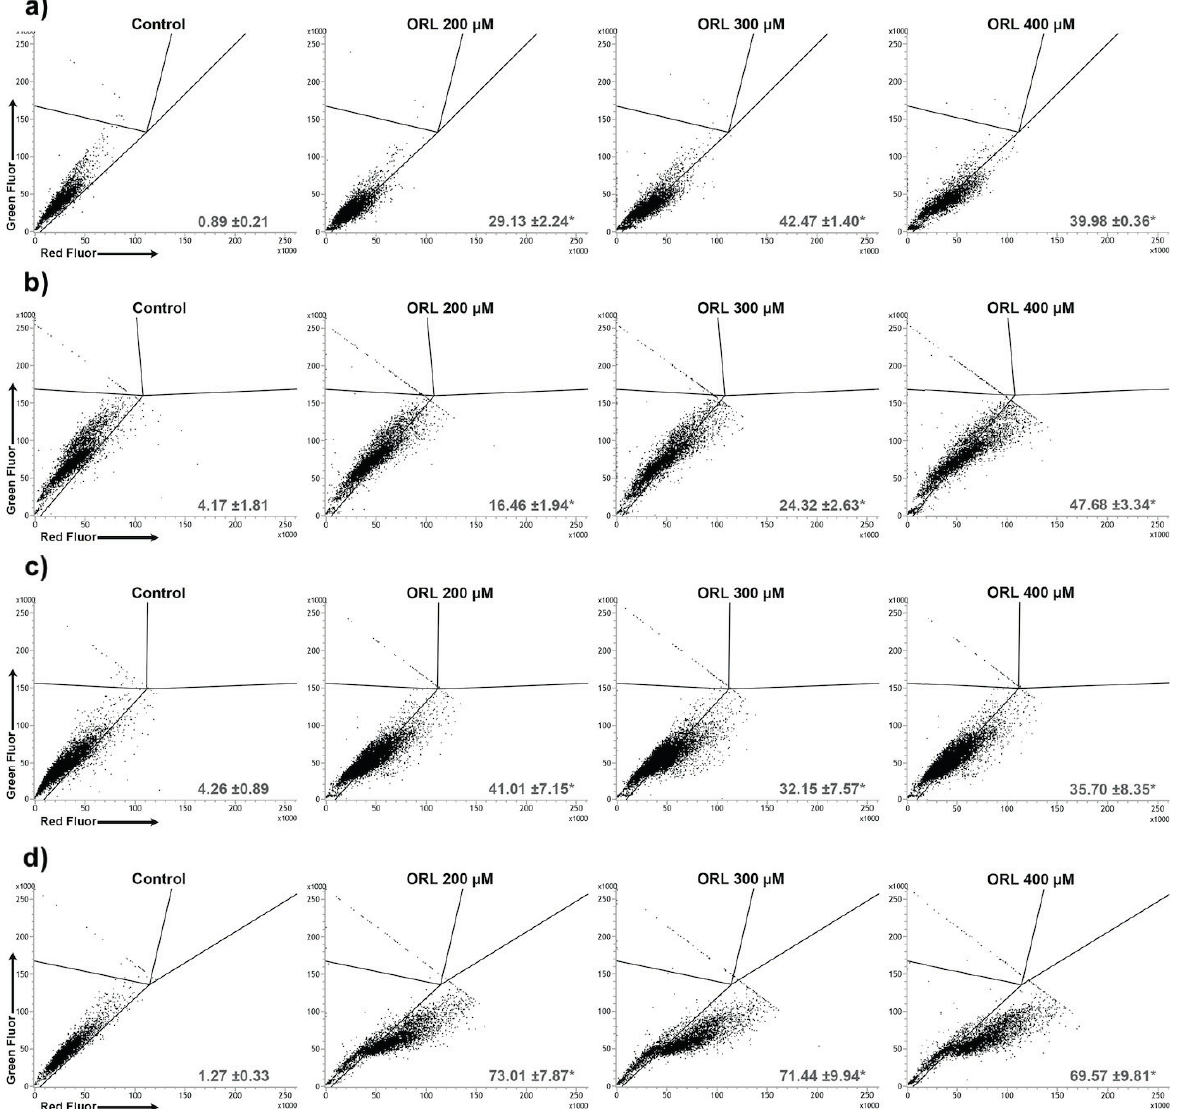
Figure 6. FASN inhibitor (orlistat - ORL) triggers autophagy in cervical cancer cell lines. Flow cytometry showed an increase in acridine orange (AO)-marked cells in the HeLa (a), SiHa (b), C-33A (c) and ME-180 (d) cell lines. Values refer to the average percentage of cells in each gate for three independent experiments ± standard deviation (SD). *p < 0.05 compared to control (one-way ANOVA followed by Tukey’s